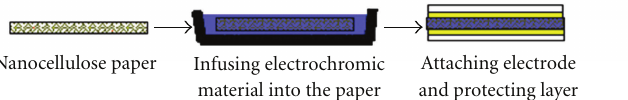
Figure 18: Fabrication process of the display using nanocellulose.